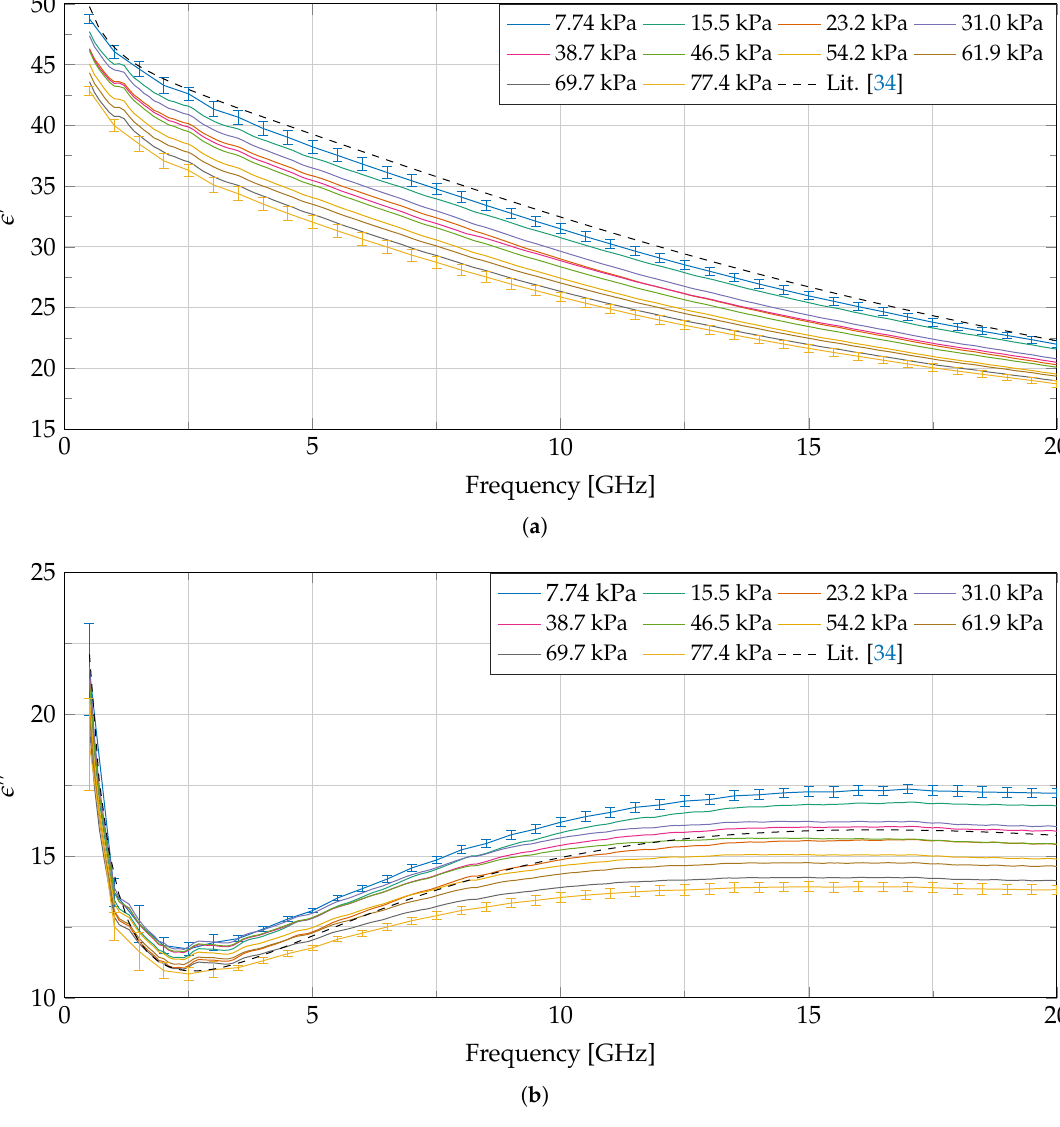
Figure 6. Measured dielectric properties (real and imaginary in respectively ( a , b )) throughout Experiment 5 at 10 different pressures and compared with the dielectric properties for liver found in [34]. The error bars from this experiment are calculated as explained in Section 2 and are added to the measurement at the lowest and highest